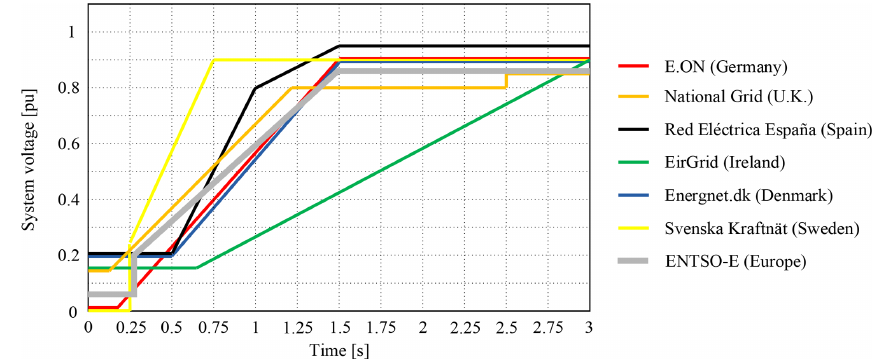
Figure 1. Example of LVRT profiles from the selected grid